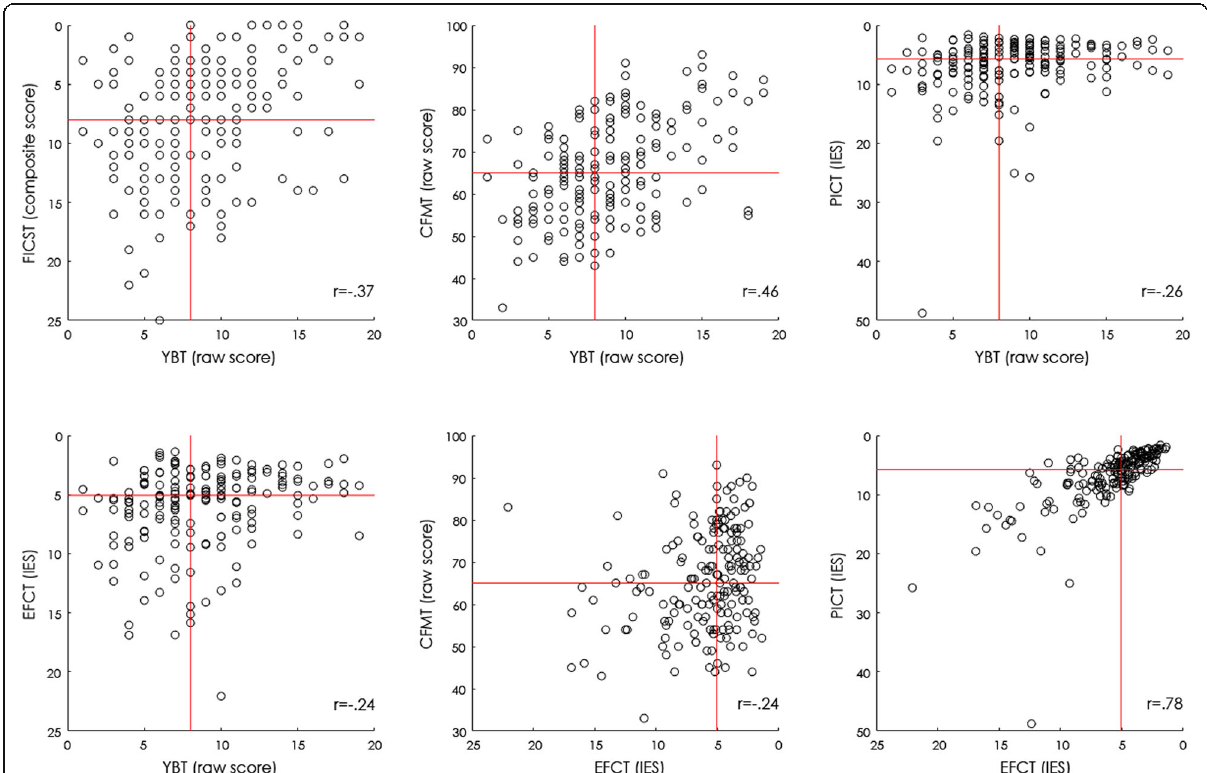
Fig. 4 Significant correlations between measures. Visualized here are the significant correlations (see Table 5) between the Yearbook Test (YBT) and Facial Identity Card Sorting Test (FICST), long form of the Cambridge Face Memory Test (CFMT+), Person Identification Challenge Test (PICT) and Expertise in Facial Comparison Test (EFCT) (top row to bottom left), as well as EFCT and CFMT+ (bottom middle), and PICT (bottom right), respectively. Red lines indicate the median of each test. IES inverse efficiency score